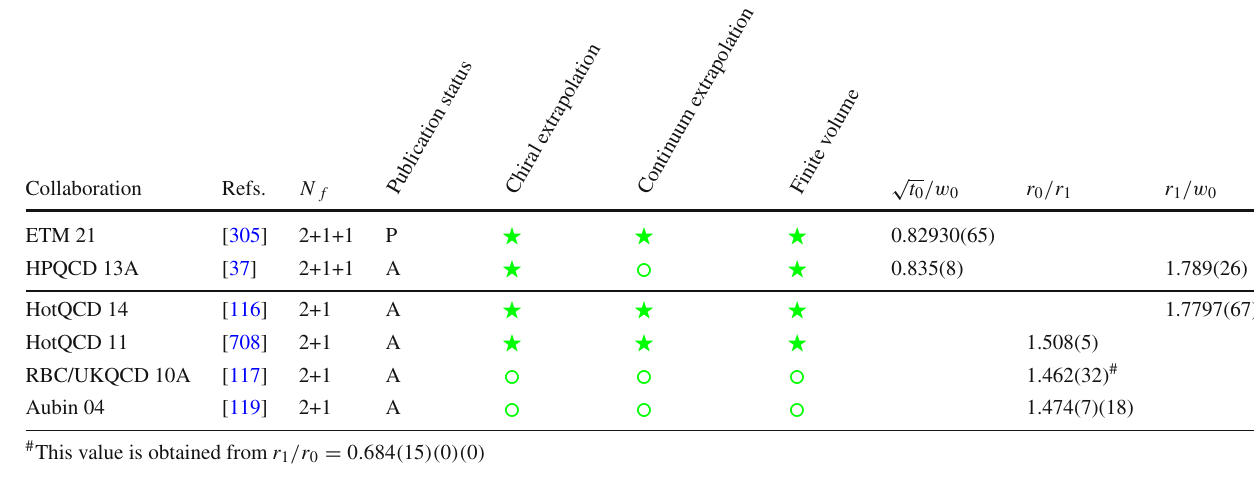
Table 78 Results for dimensionless ratios of scales